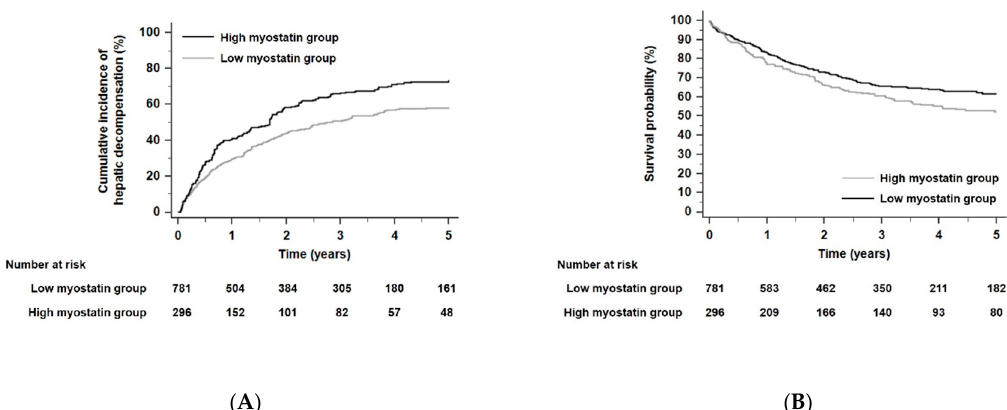
Figure 5. Kaplan–Meier estimates of hepatic decompensation event ( A ) and liver-related death ( B ) in ALC patients according to serum myostatin levels (all p < 0.001 by log-rank test). Abbreviations: ALC, alcoholic liver cirrhosis.